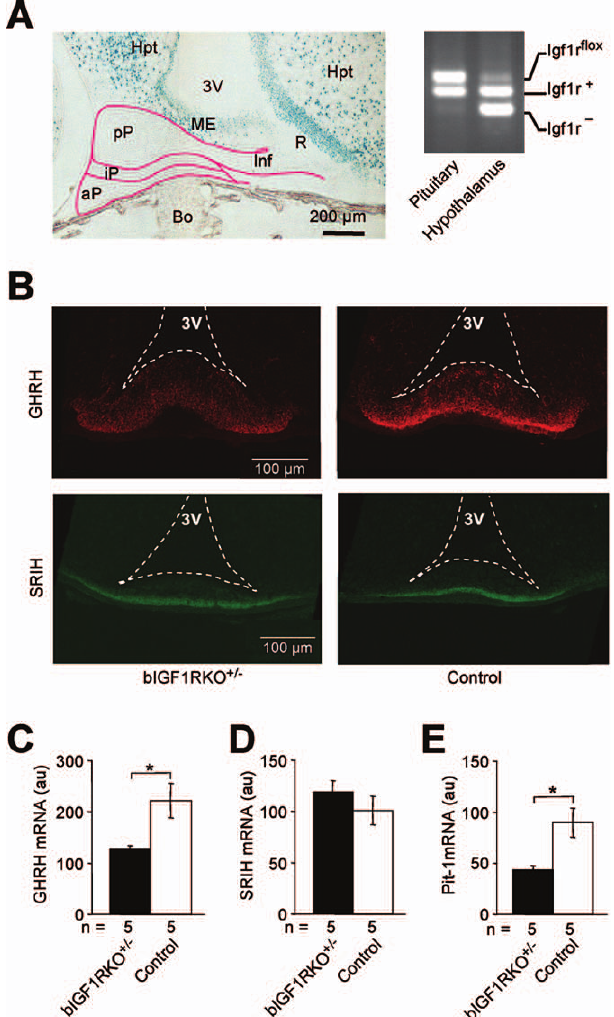
Figure 3. Somatotropic Signals in the Hypothalamic-Pituitary Complex (A) Efficient Cre-lox recombination in hypothalamus, not in pituitary, as shown by X-Gal-staining of a sagittal NesCre þ /0 ;Rosa26R þ /0 brain section: the anterior pituitary originates from the pharyngeal wall, not from neuroepithelium, to which NesCre transgene expression is confined. Abbreviations: 3V, third ventricle; aP, anterior pituitary; Bo, bone; Hpt, hypothalamus; Inf, infundibulum; iP, intermediate pituitary; ME, median eminence; pP, posterior pituitary; R, recessus of the third ventricle. PCR analysis of genomic DNA confirmed absence of recombination from the pituitary: intact Igf1r flox alleles in pituitary, and knockout ( Igf1r (cid:2) ) alleles prevalent in hypothalamus. (B) GHRH immunoreactivity (red) at nerve endings in the ME was weaker than control in bIGF1RKO þ / (cid:2) mice (65 6 6 versus 122 6 10 au (arbitrary units), p , 0.01, n ¼ 3), whereas SRIH (green) was unaffected (191 6 3 versus 197 6 5 au, n ¼ 3). Briefly, ME tissue sections from the same anatomical location in three bIGF1RKO þ / (cid:2) and three control 10-day-old males were subjected to IHC. Micrographs were taken under identical conditions. For each animal, data from ten sections were averaged. The ratio of GHRH to SRIH immunoreactivity was lower in bIGF1RKO þ / (cid:2) than in control animals (0.34 6 0.05 versus 0.54 6 0.09, n ¼ 6; p ¼ 0.06). (C) Similarly, GHRH gene expression (measured by quantitative real-time RT-PCR, relative to b -actin) was lower at age 10 d in mutants than controls. (D) SRIH expression was similar in mutants and controls. (E) Pit-1 expression (relative to 18S rRNA) was lower in bIGF1RKO þ / (cid:2) than wild-type pituitaries at age 10 d.